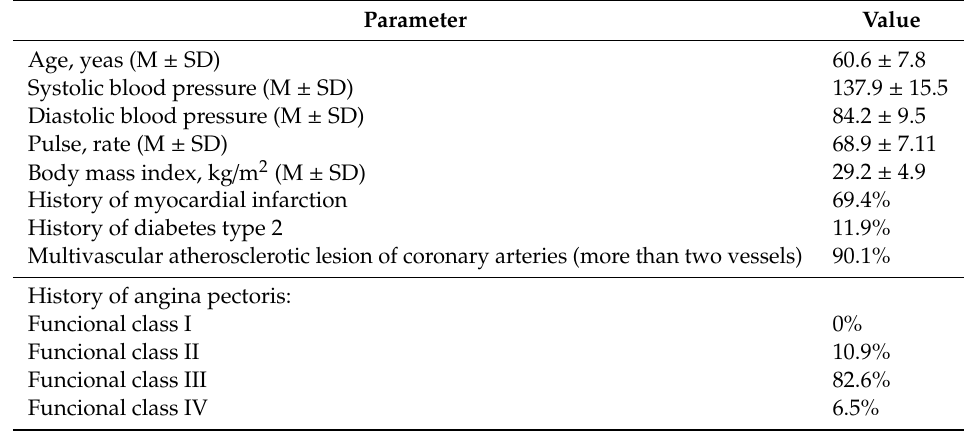
Table 1. Clinical characteristics of patients with coronary